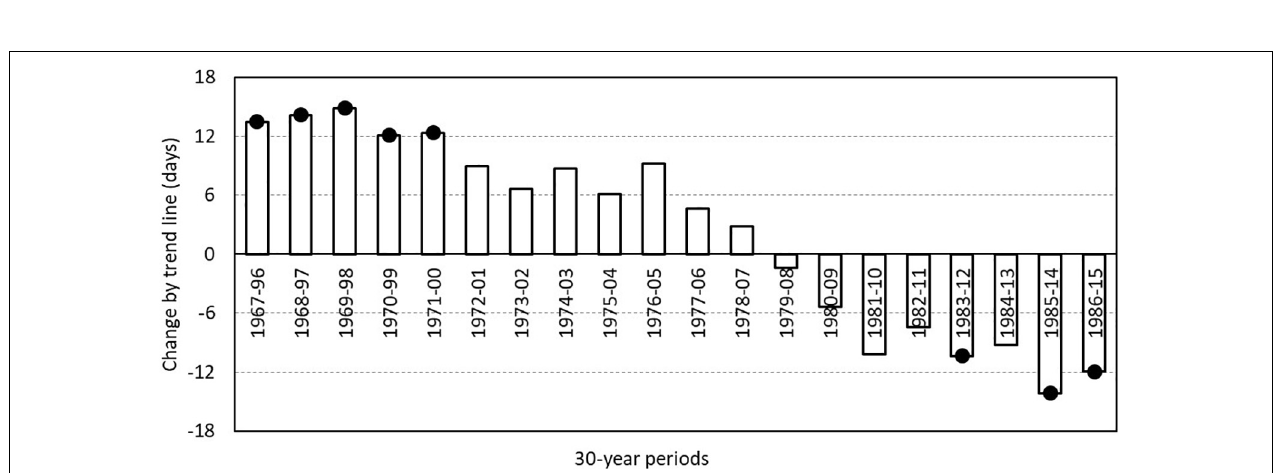
FIGURE 4 | Frequency (in days) of CAP09 classification circulation type W and change by trend line in days in winter (1967–2015). Long trend line is for the whole period 1967–2015. Two shorter ones are for 1967–1991 and 1992–2015. Both short trend lines are statistically significant ( p < 0.05), the long one is not.